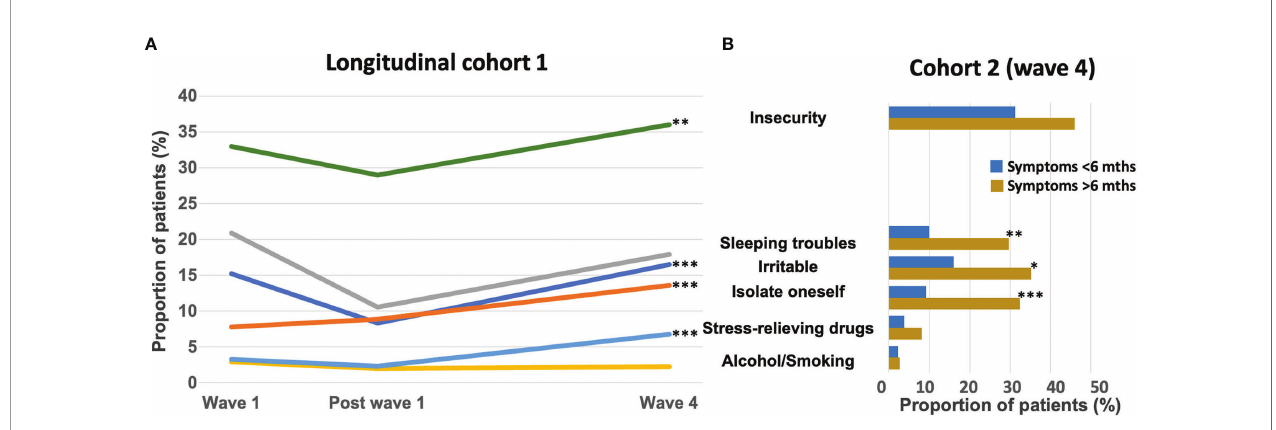
FIGURE 5 | Proportion of patients in (A) cohort 1 (longitudinal cohort) experiencing insecurity, sleeping troubles, feeling irritable or the need to self-isolate, to consume stress-relieving drugs, alcohol, or tobacco during the pandemic at wave 1, post wave 1, and at wave 4. (B) Proportion of patients experiencing these feelings in cohort 2 (at wave 4) among patients tested positive according to the duration of COVID symptoms (less than 6 months in blue, or more than 6 months in brown). Mths: months; *p<0.05; **p<0.01;